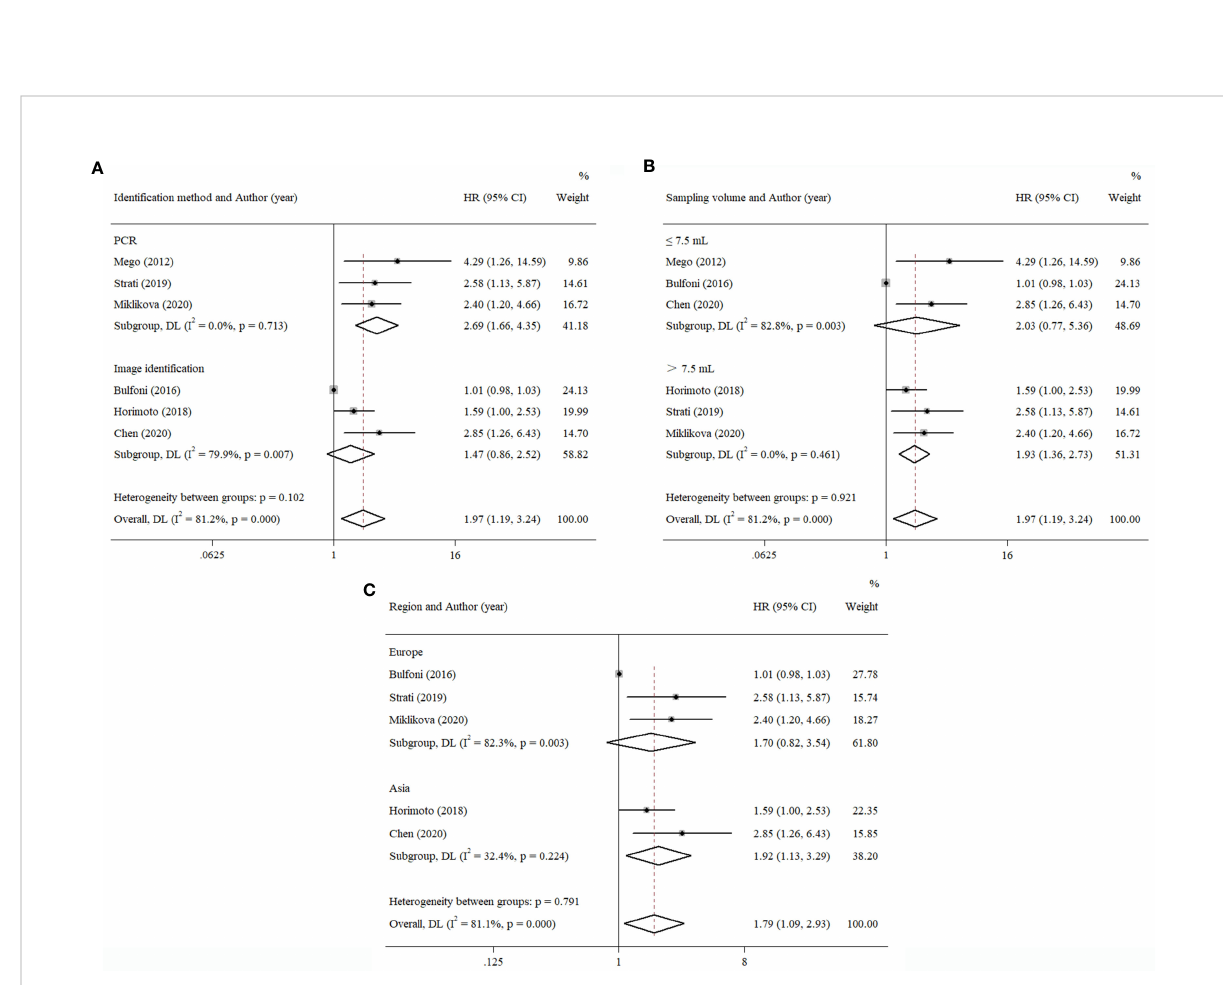
FIGURE 6 Subgroup analysis of the prognostic value of EMT-CTCs with different (A) identi fi cation methods, (B) sampling volumes, and (C)